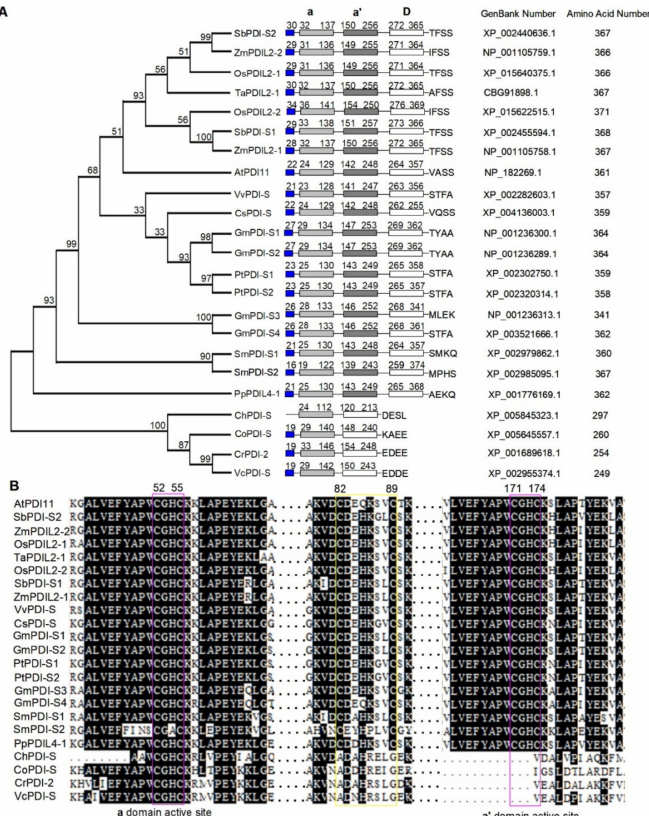
Figure 1. Phylogenetic analysis and protein sequence alignment of PDI-S from various species. ( A ) Phylogenetic analysis of AtPDI11 and its homologs in different species. A